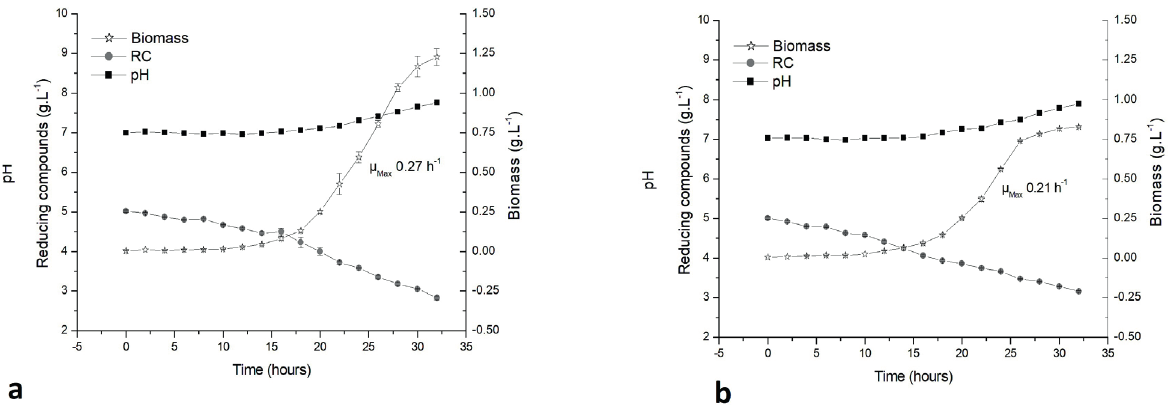
Figure 2 - Cell growth of Cupriavidus necator using hydrolyzed extracts of orange wastes ( a ), and passion fruit ( b ), as the only carbon